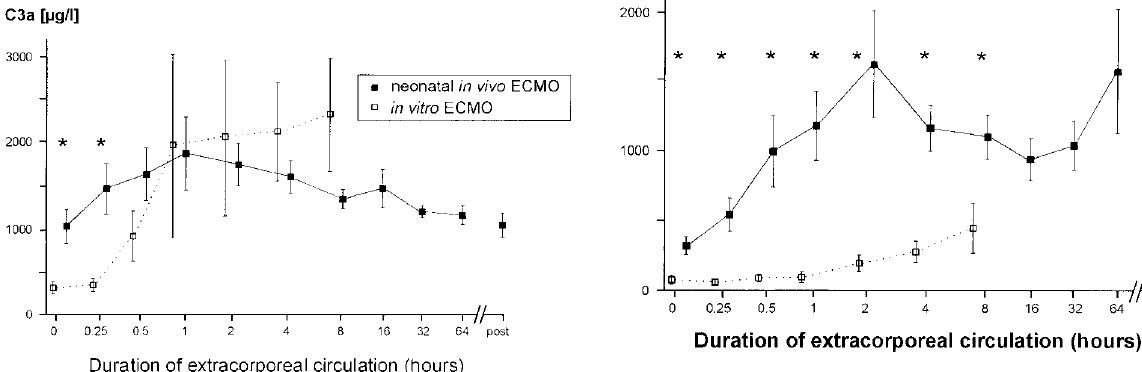
FIG. 3. sC5b-9 concentration (mean ± SEM) of in vivo neonatal ECMO and in vitro ECMO ( n = 6 for both groups). In neonatal in vivo ECMO, sC5b-9 is higher compared with the in vitro situation (* p < 0.05 by Mann–Whitney U test). Both groups demonstrate a significant increase during the obser- vation period (Friedman variance analysis). Post, 12h after